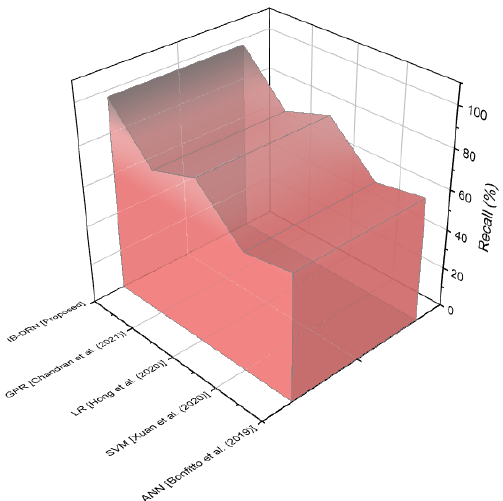
Figure 5. Recall results of proposed and existing methodologies [ANN [Bonfitto et al. (2019)], SVM[Xuan et al. (2020)], LR[Hong et al. (2020)], GPR [Chandran et al. (2021)]].